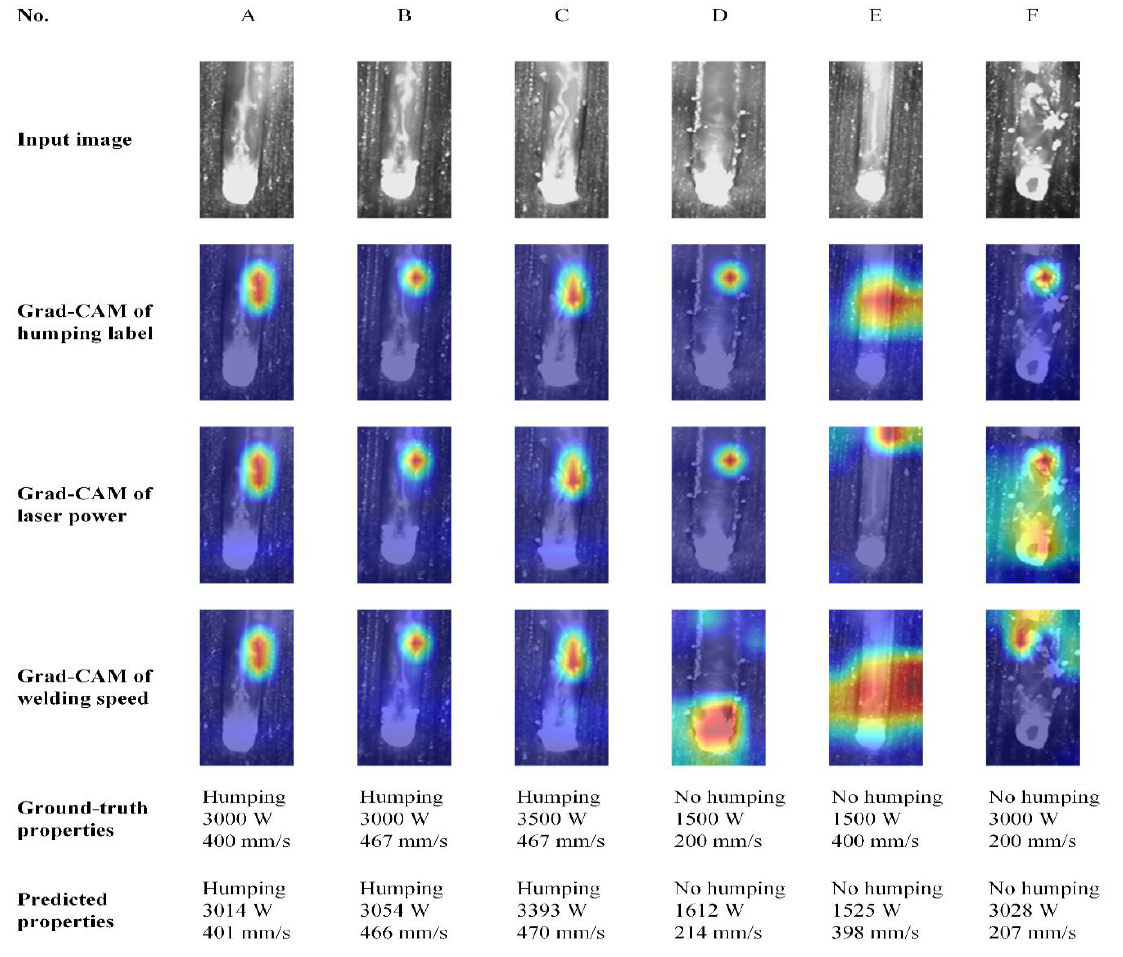
In Grad-CAMs of humping label, for all six samples, the highlighted region is mainly concentrated on the melt pool region in the upper part of the image. In fact, the appear- ance of this region will exactly change once humping occurs. The appearance of the melt pool when humping occurs is shown in Figure 13, which is usually accompanied with